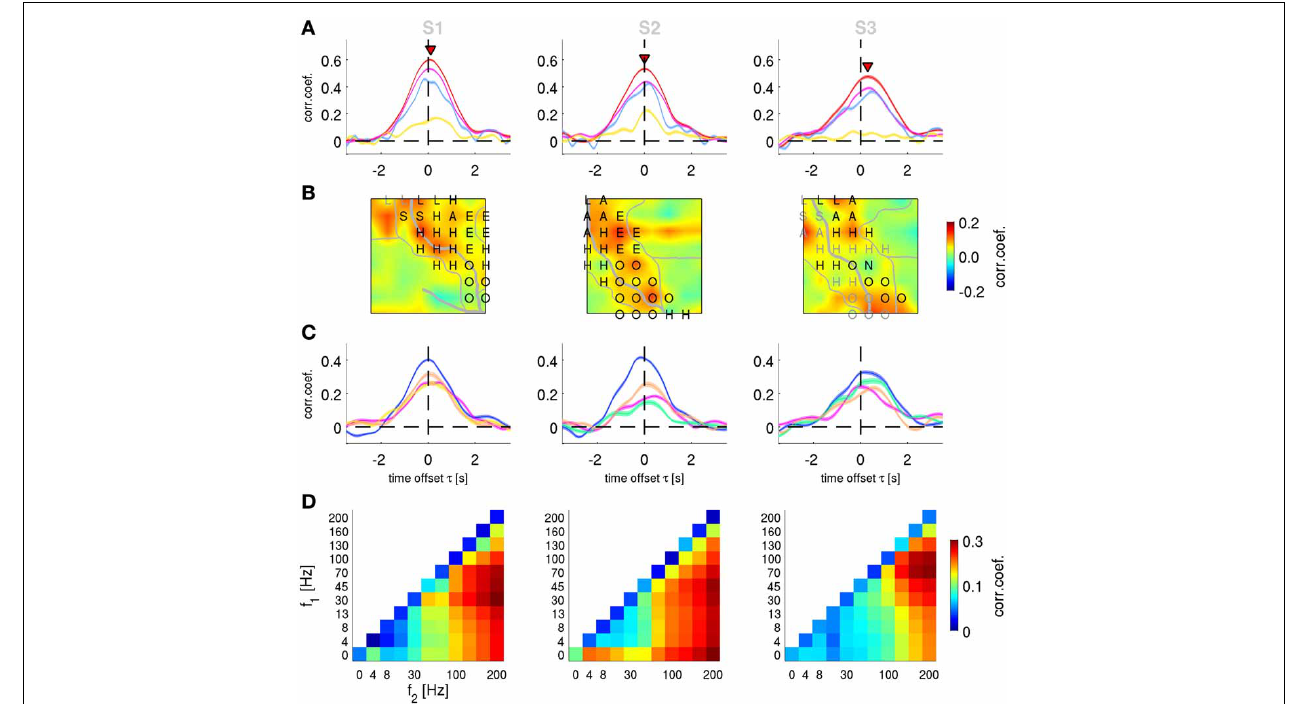
FIGURE 7 | Decoding of velocity from different signal components and anatomical areas. Results for subjects S1–S3. (A) All grid channels decoding. Mean CC ± s.e.m. as a function of time offset τ between ECoG predictors and decoded movement velocity (negative values of τ indicating that the ECoG preceeds in time the movement execution). The 4 different features analyzed are: time-frequency magnitude and phase (red), time-frequency phase-only (magenta), time-frequency magnitude-only (yellow), and time domain LFC (cyan). Decoding accuracy of time-frequency magnitude and phase features at their peak values (labeled with red triangles) are significantly better than those of the time domain LFC. (B) Time-frequency magnitude and phase decoding using single channels and time offset τ indicated by red triangles in (A) . The square plots represent the ECoG grid of each subject, with marked central (and in S1 lateral) sulcus (thick white curve on the grid), division of anatomical areas (thin white lines,